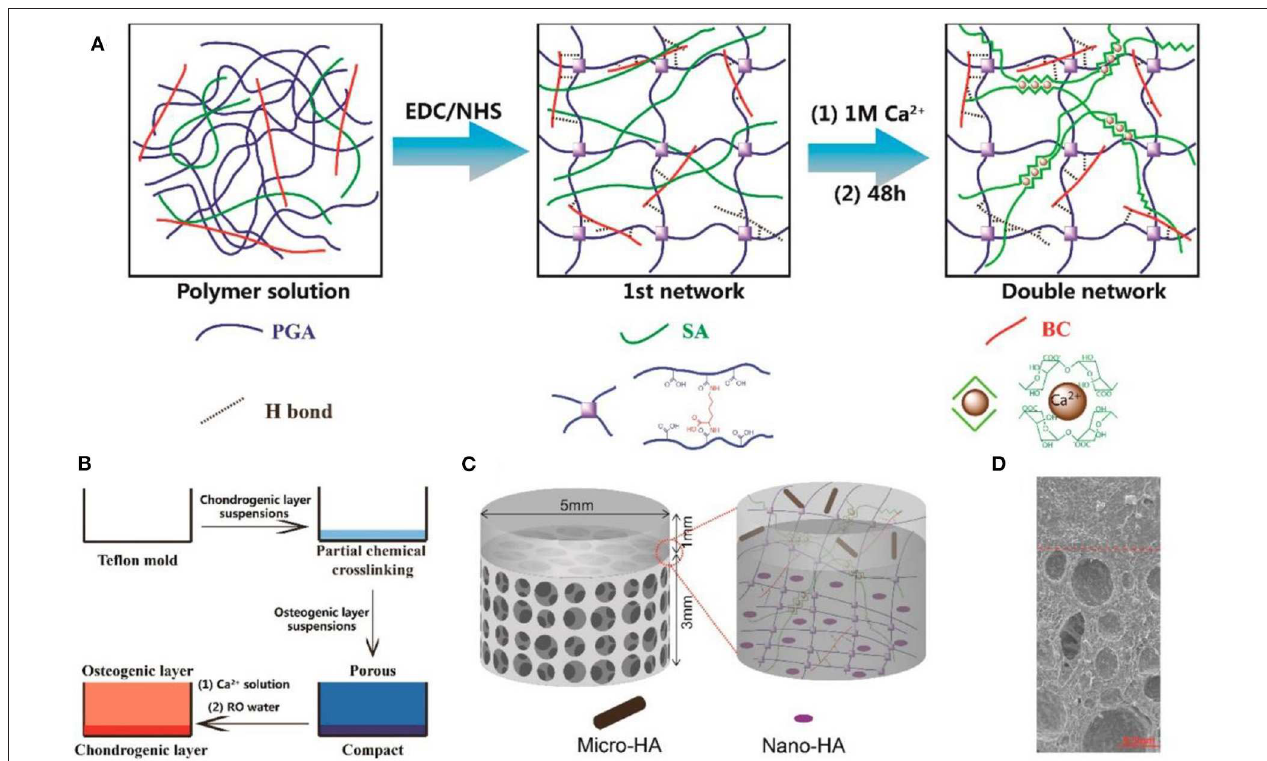
FIGURE 2 | Schematic illustration of (A) preparation process of BC-DN hydrogels, bilayered hydrogel scaffolds, and the structure of bilayer hydrogel. (B) Schematic depiction of the preparation of bilayer hydrogel scaffolds. (C) Schematic illustration of the structure of the bilayer hydrogel. (D) SEM image of bilayer hydrogel scaffolds. Reproduced from Zhu X. B. et al. (2018) with permission from Copyright 2018 American Chemical